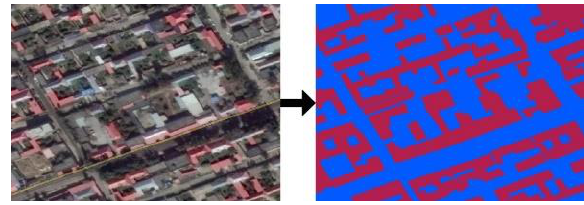
Figure 4. Building area extraction based on K adjacent classification